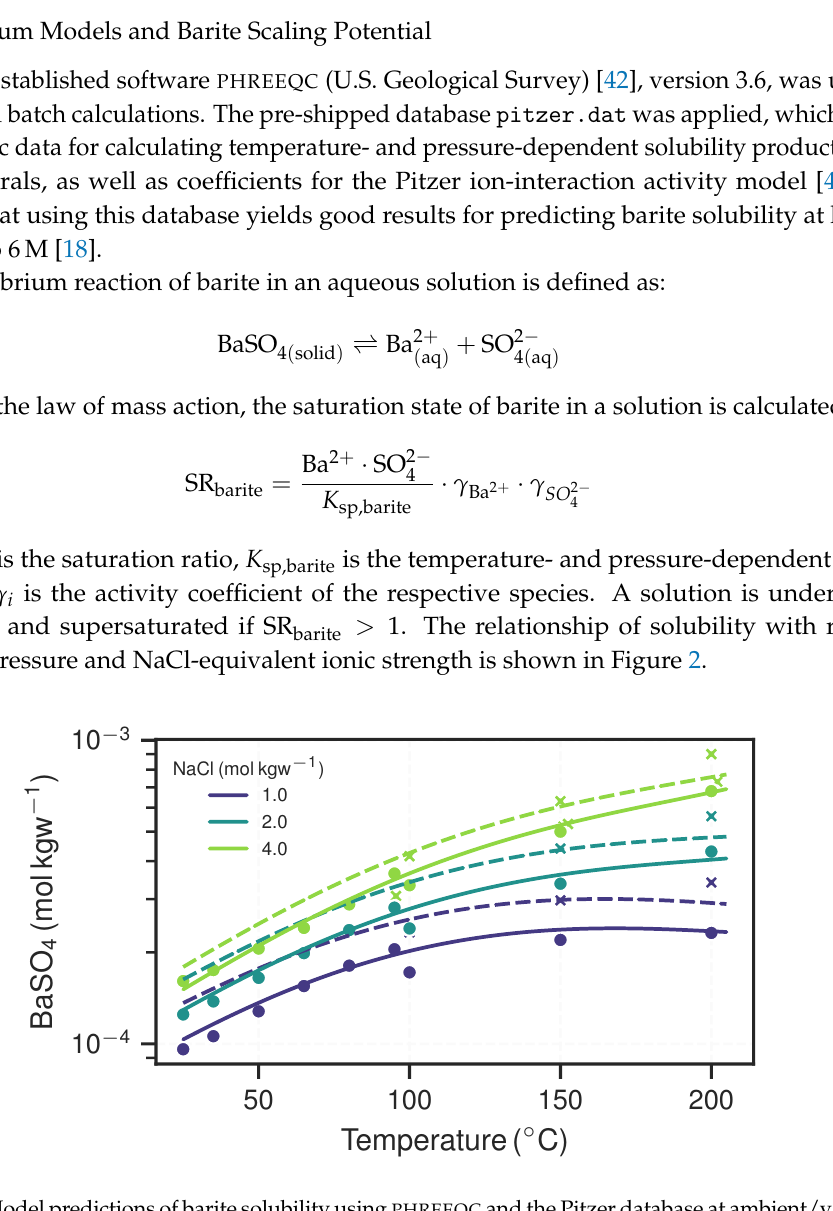
Figure 2. Model predictions of barite solubility using PHREEQC and the Pitzer database at ambient/vapour pressure (solid lines) and 50MPa (dashed lines) for various temperatures and NaCl-contents. The markers represent experimental values from Blount [16] (circles) and Templeton [17]